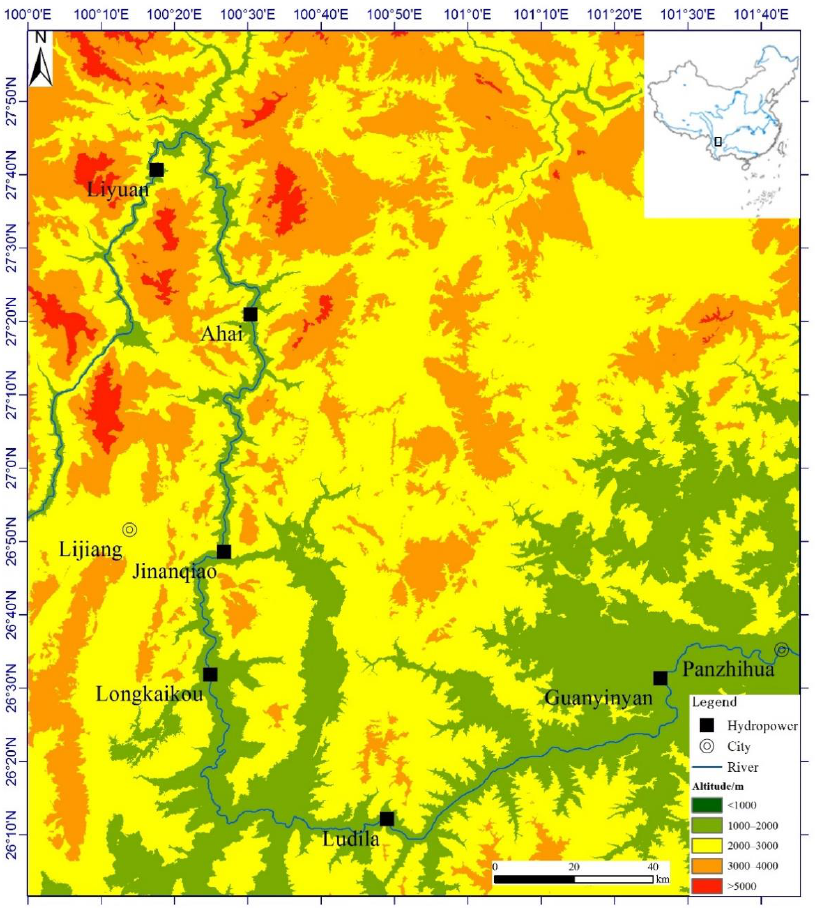
Figure 1. Distribution map of hydropower stations on the main course of the middle reach of the Jinsha River (DEM data from the website https://www.gscloud.cn/ and accessed on 8 November 2021).